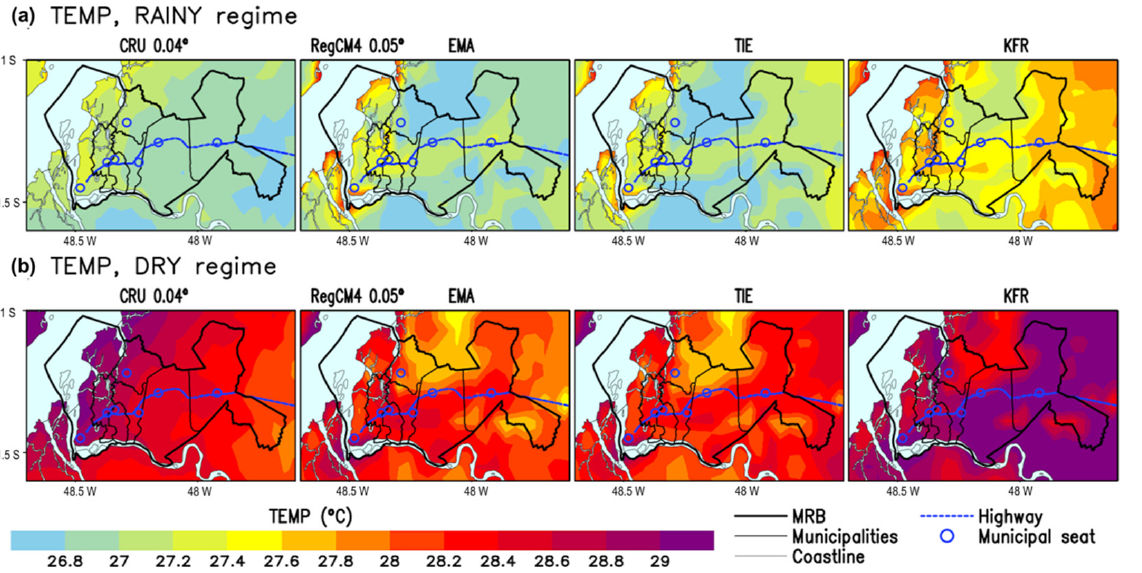
Figure 6. CRU observed and RegCM4 simulated TEMP (°C) using EMA, TIE, and KFR schemes for ( a ) RAINY; ( b ) DRY regime.